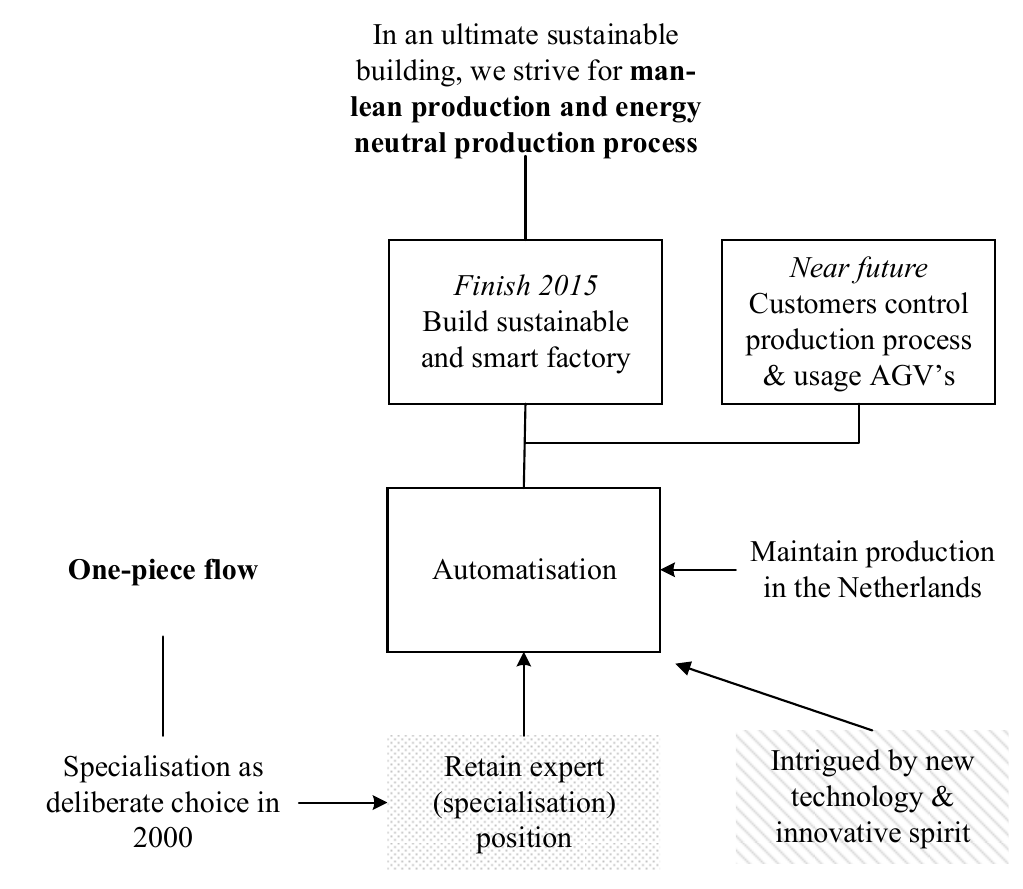
Figure A6. Flow chart for Itter.